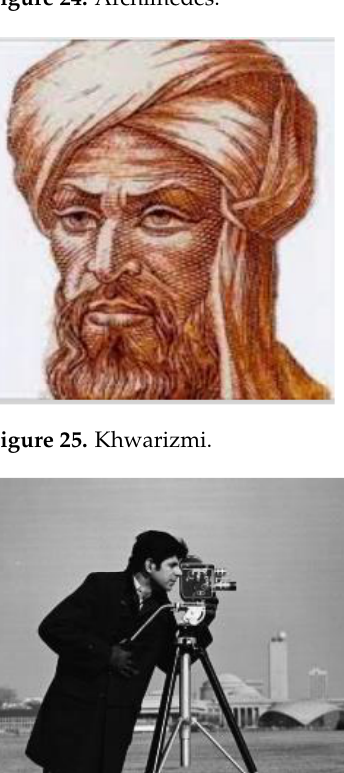
Figure 25. Khwarizmi.